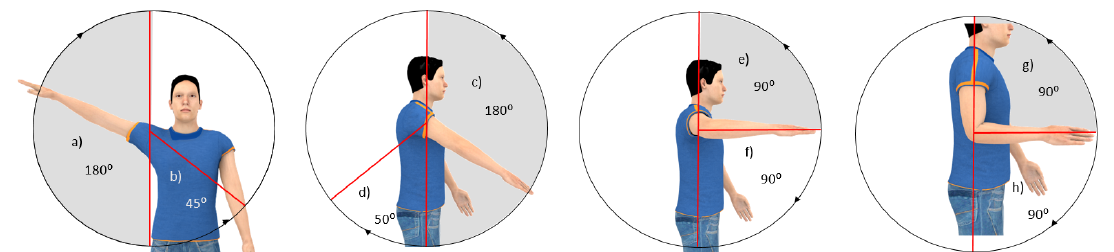
Figure 2. Maximum ranges of movements in the upper limb: ( a ) abduction, ( b ) adduction, ( c ) shoulder flexion, ( d ) shoulder extension, ( e ) external rotation, ( f ) internal rotation, ( g ) elbow flexion, ( h ) elbow extension.